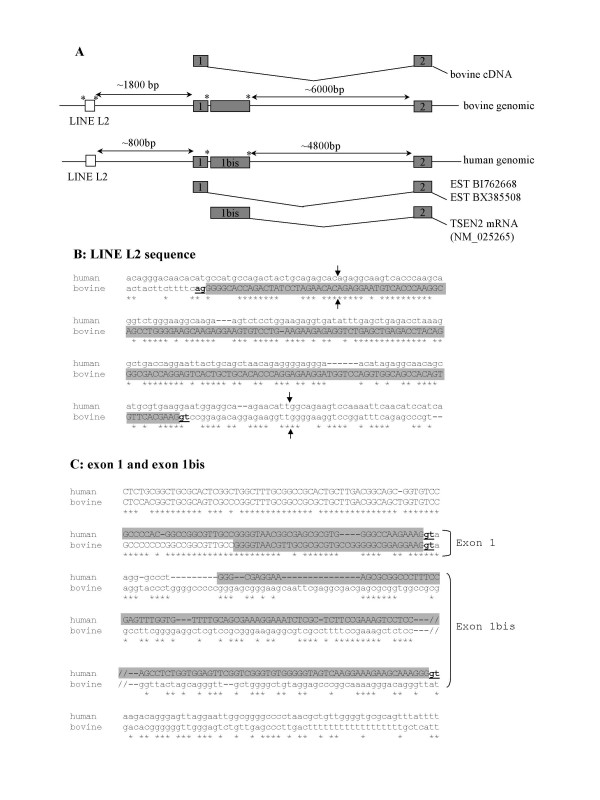
Comparison of the structure and sequence of the TSEN2 gene 5'end between human and cattle. A- Genomic structure of the region with the alternative untranslated exons 1 and 1bis and corresponding cDNAs. Stars indicate the presence of donor/acceptor splice sites. B- Sequence alignment of the LINE L2 repeat sequence. Arrows indicate the beginning and end of the LINE L2 as detected by Repeat Masker in both species. C- 5'untranslated exons 1 and 1bis (partial sequence) of the TSEN2 gene. Regions that are transcribed are outlined in grey, splice sites are in bold/underlined.